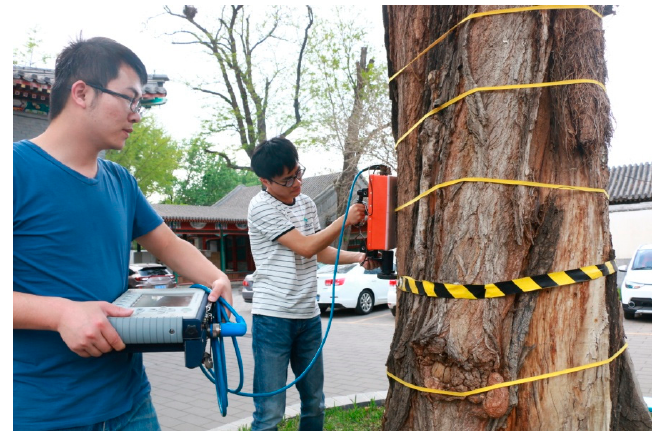
Figure 7. Field experiment.